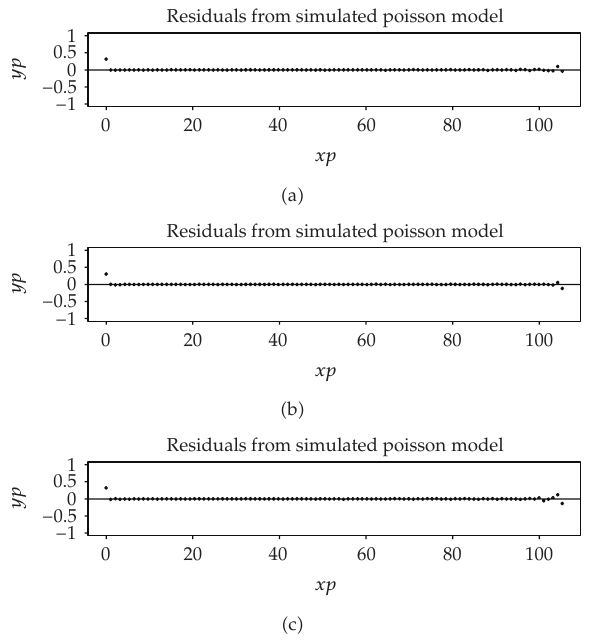
Figure 7: Correlograms for simulated deviance